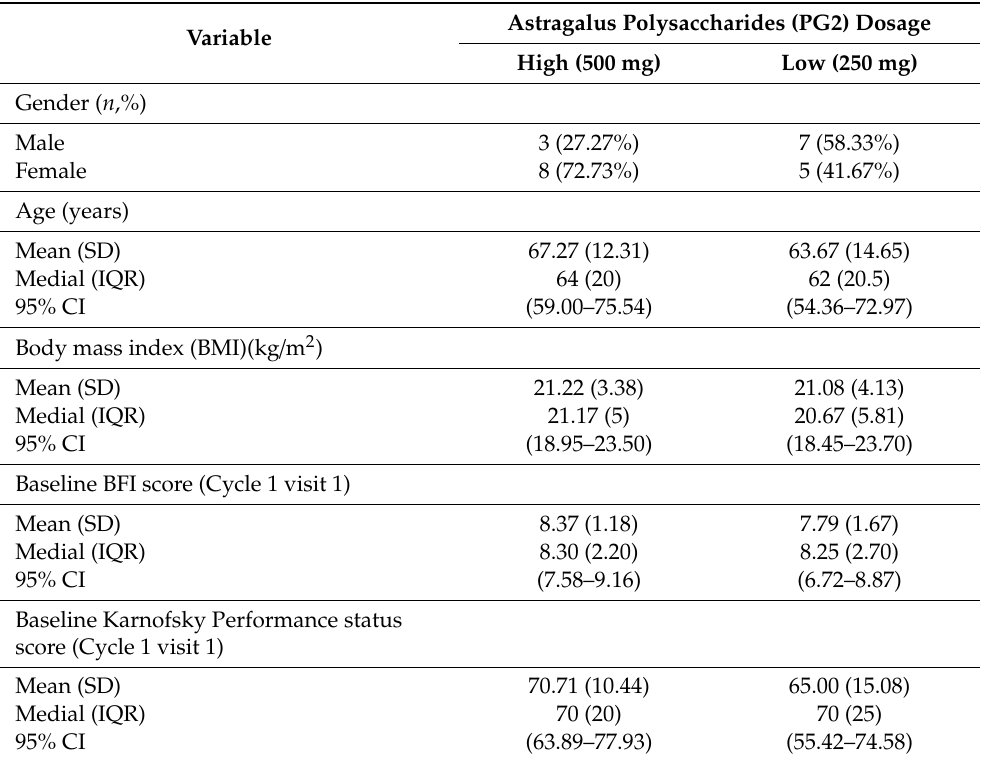
Table 1. Cohort clinico-demographic